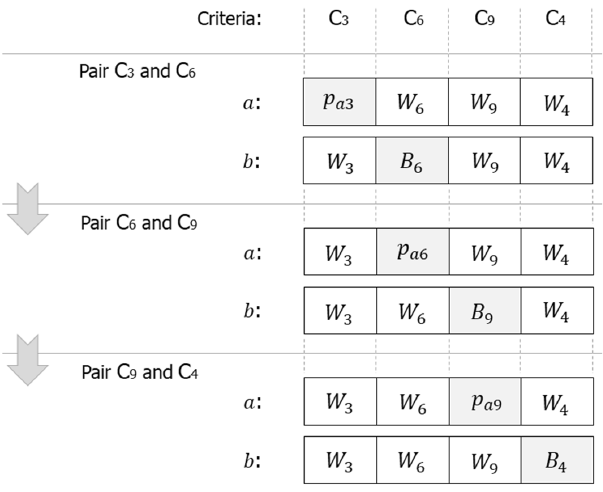
Fig. 2. Questions in the trade-off procedure – example for Case A, DM 𝐷